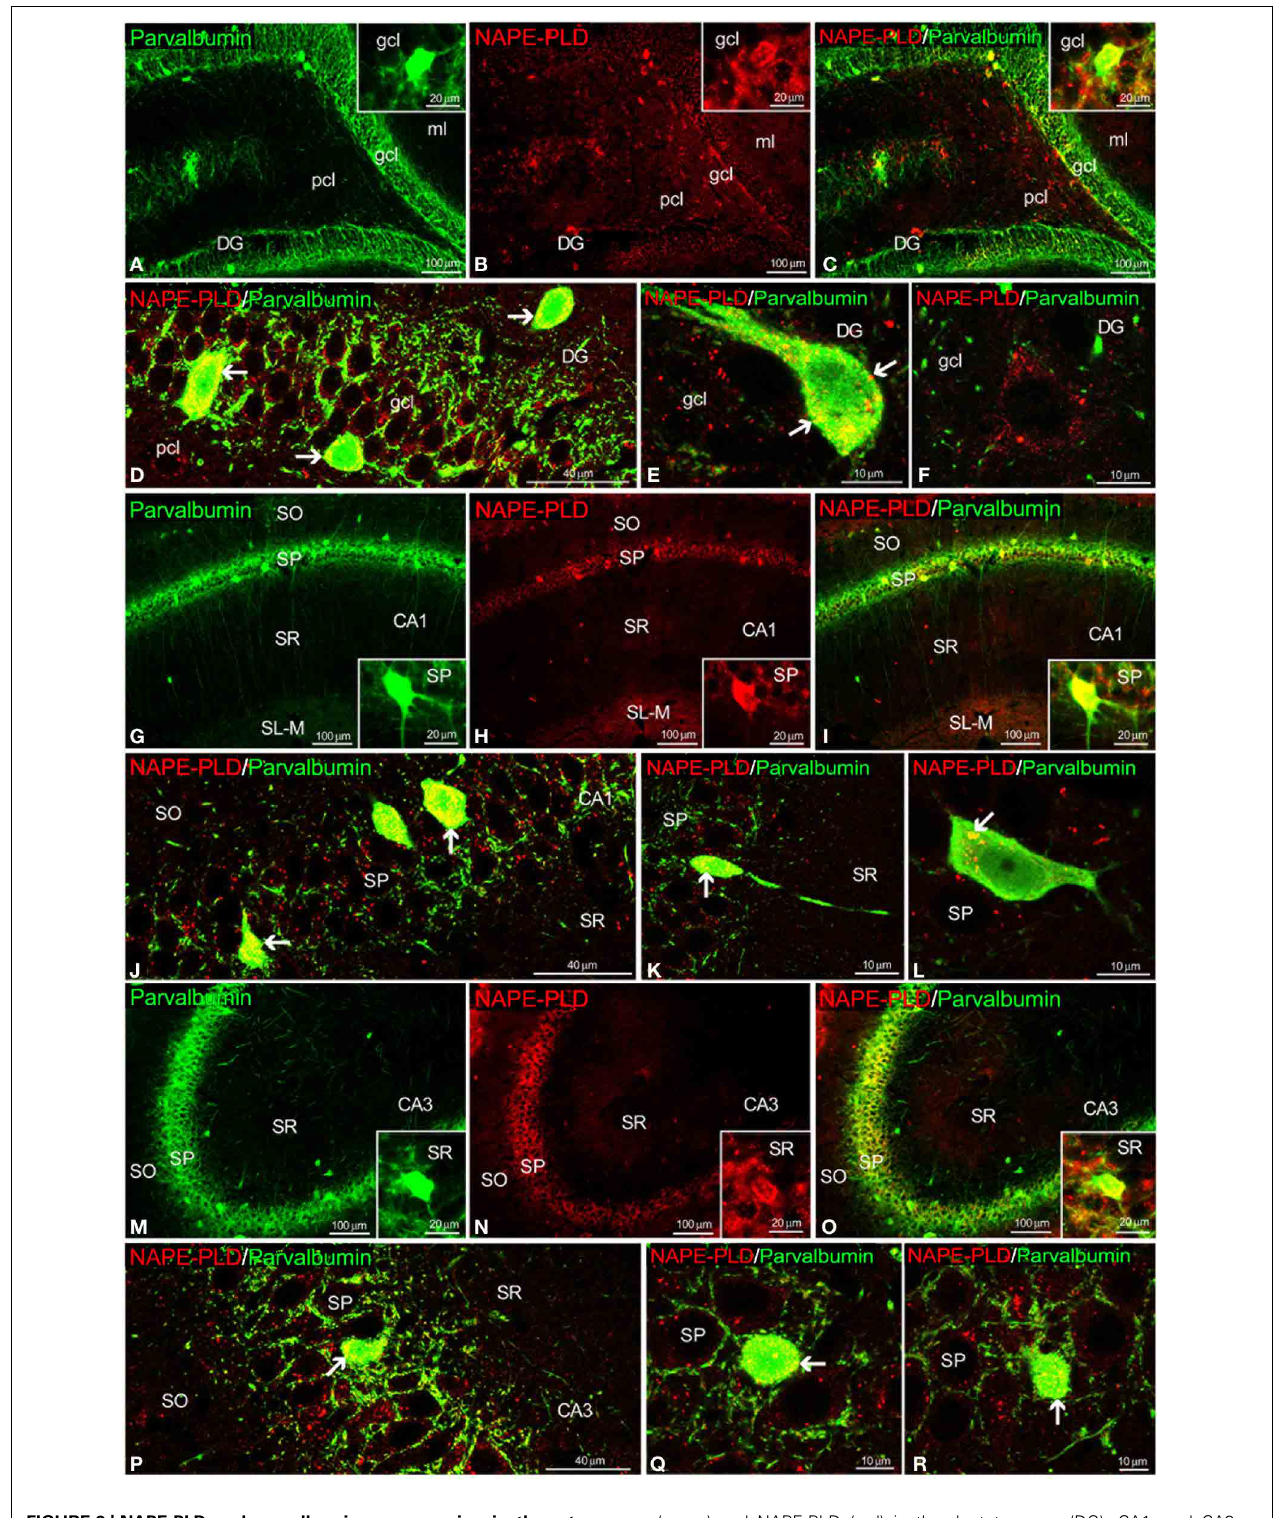
(green) and NAPE-PLD (red) in the dentate gyrus (DG), CA1, and CA3 areas. The arrows indicate NAPE-PLD expression in the parvalbumin + cells. For abbreviations, see Table 3 legend. Scale bars are indicated in each